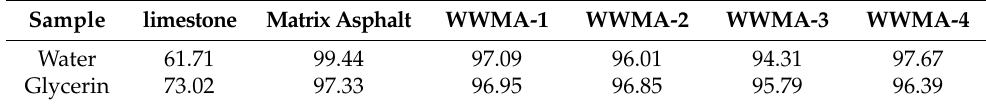
Table 7. Contact angles of the liquid on the surface of all asphalt samples (°).